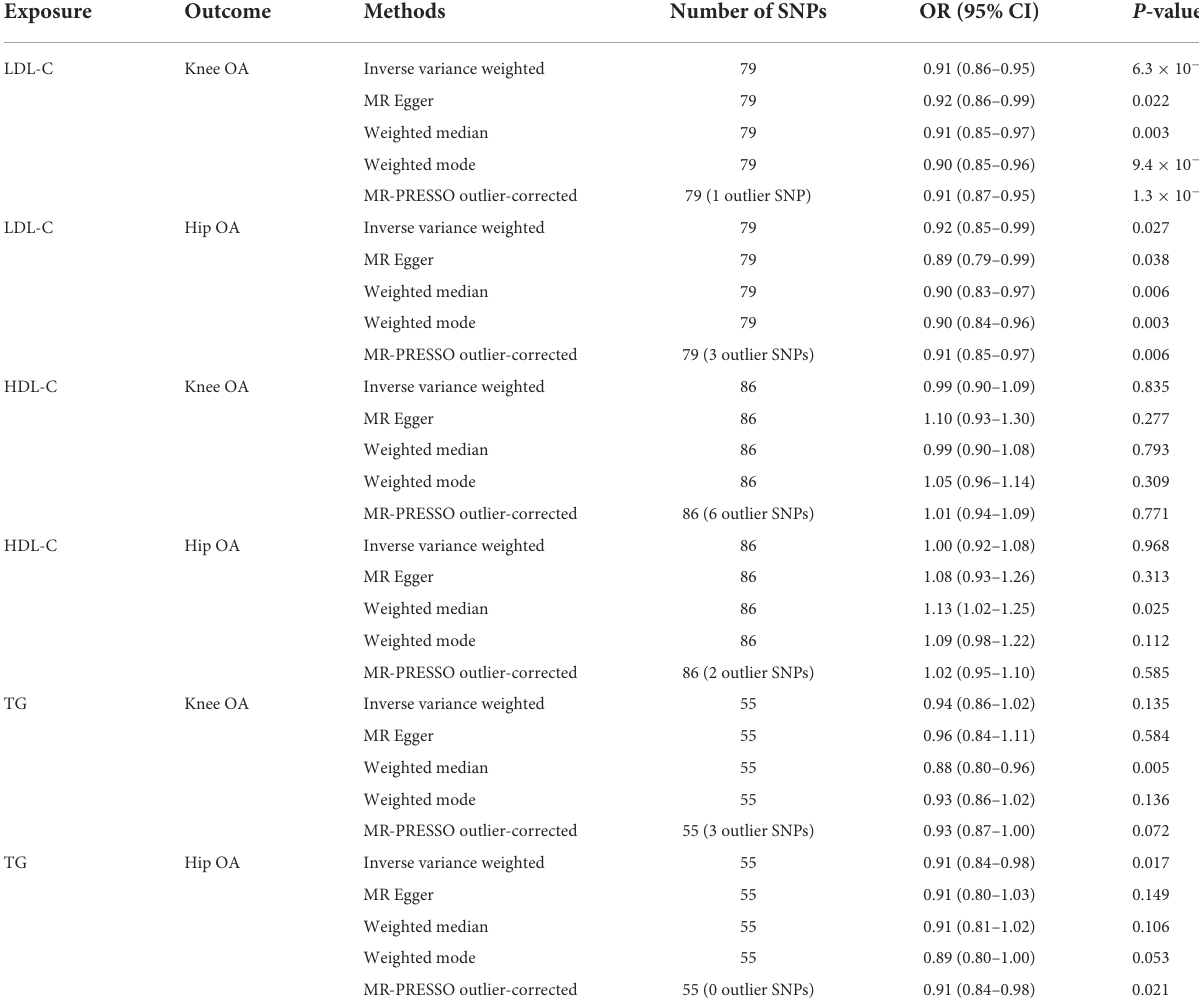
TABLE 1 Univariate Mendelian randomization analysis results.